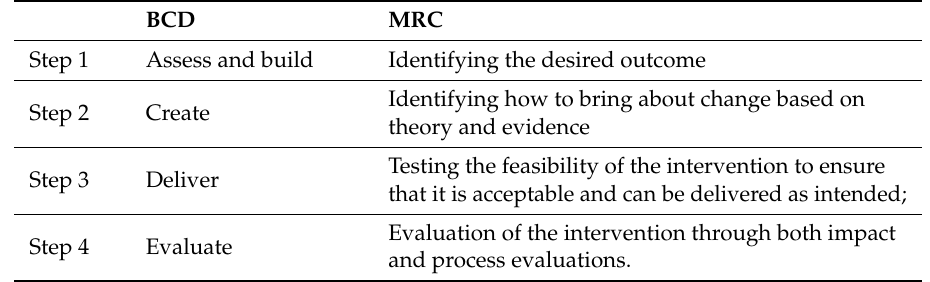
Table 1. Comparison between steps in Medical Research Council (MRC) and Behaviour Centred Design (BCD) frameworks.